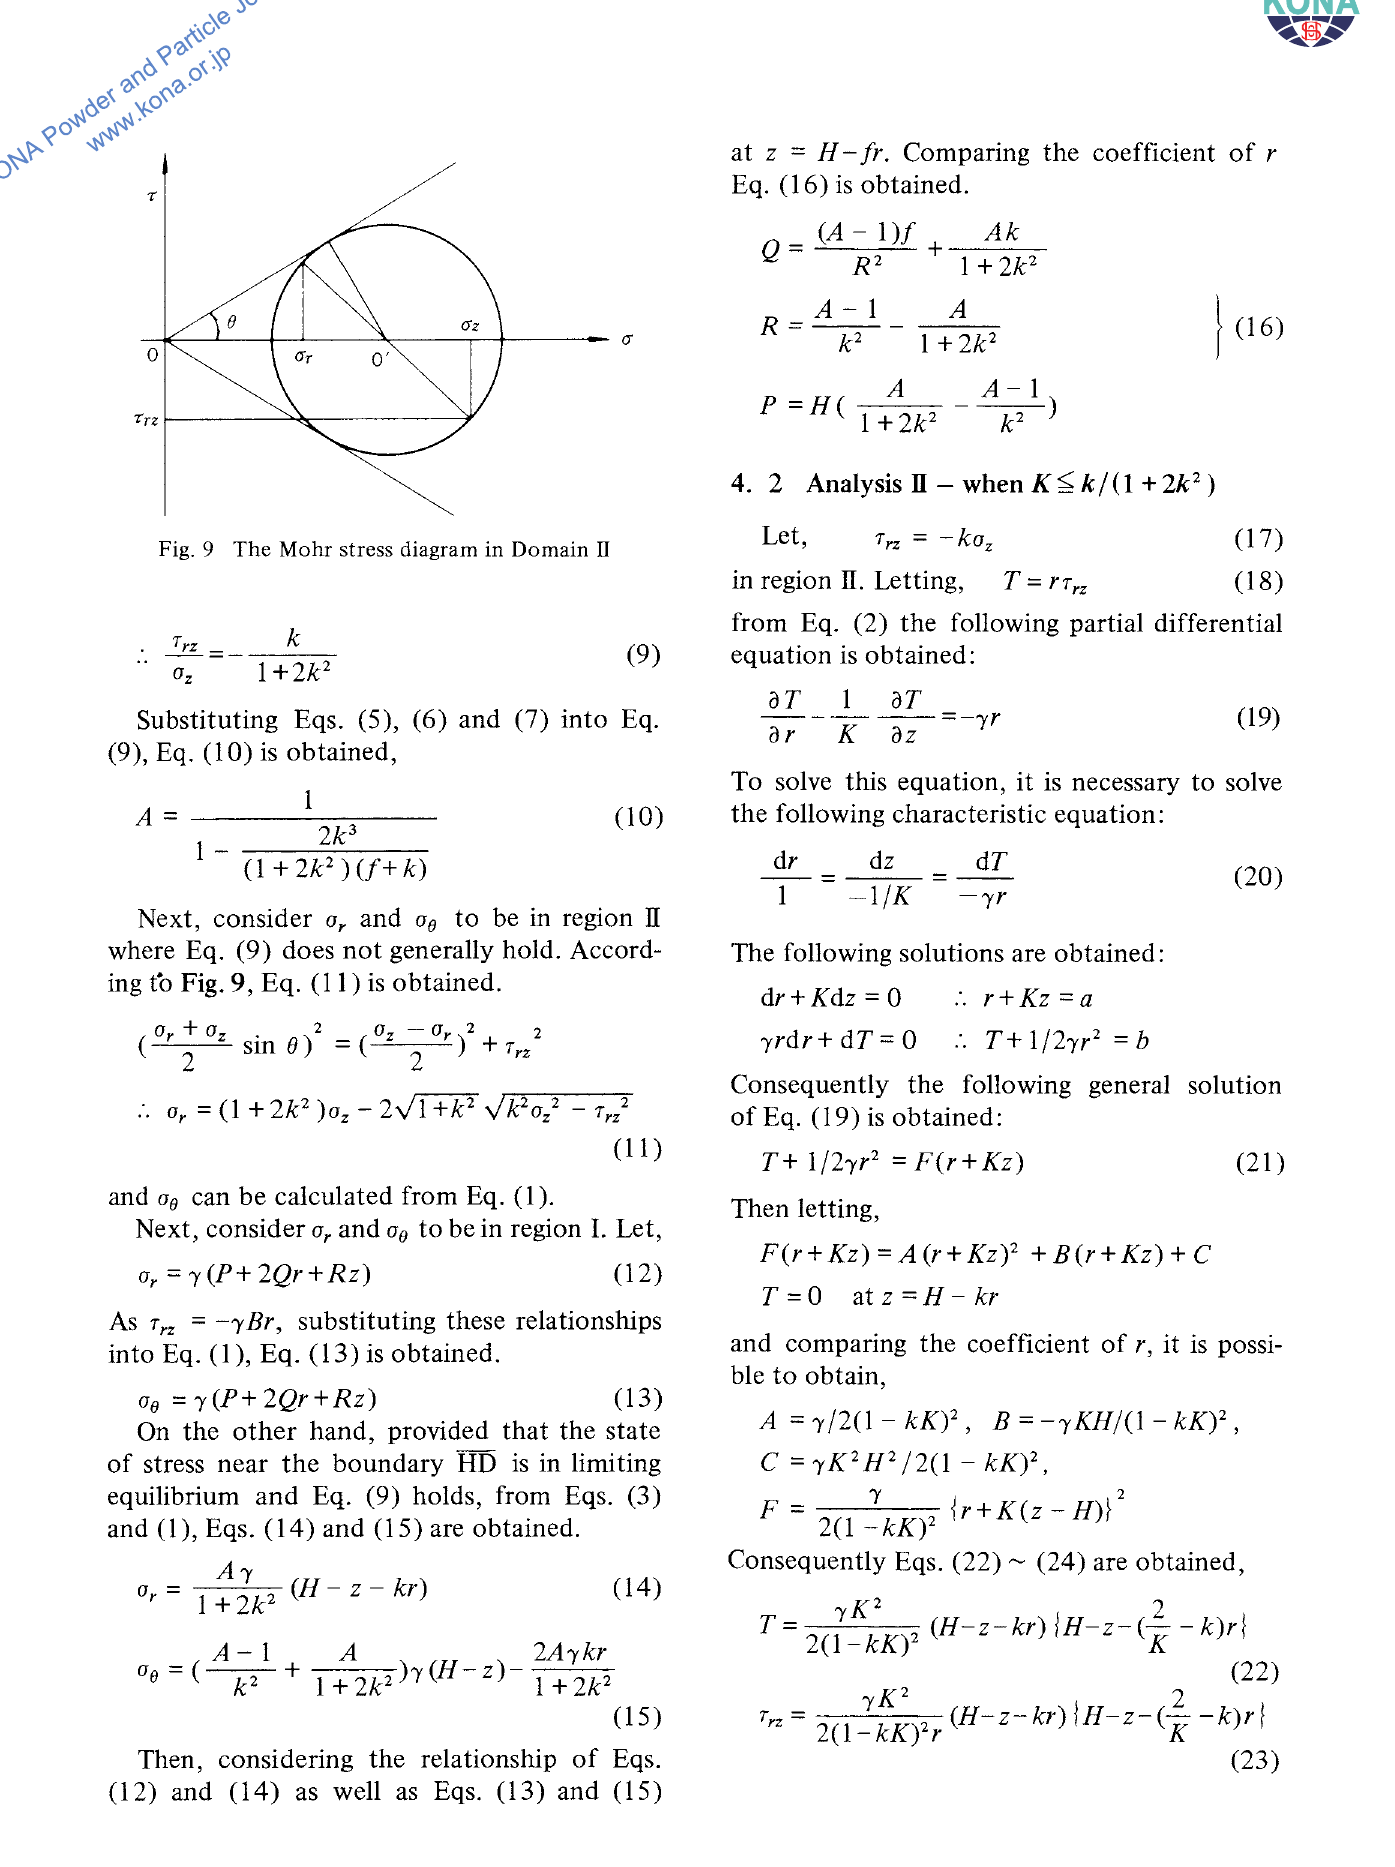
Fig. 9 The Mohr stress diagram in Domain